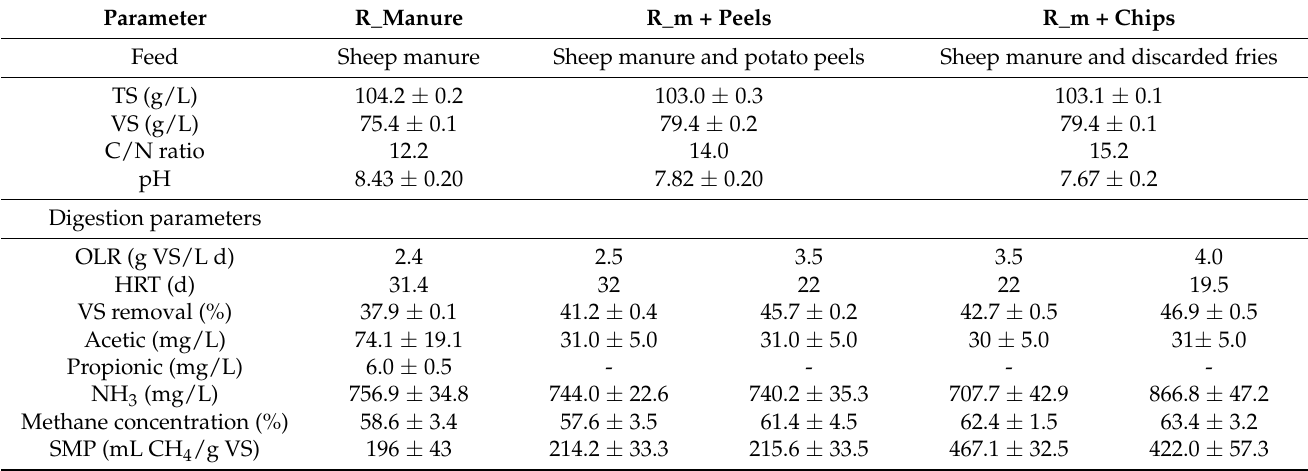
Table 3. Results from semi-continuous reactors treating sheep manure and mixture of potato peel waste and discarded